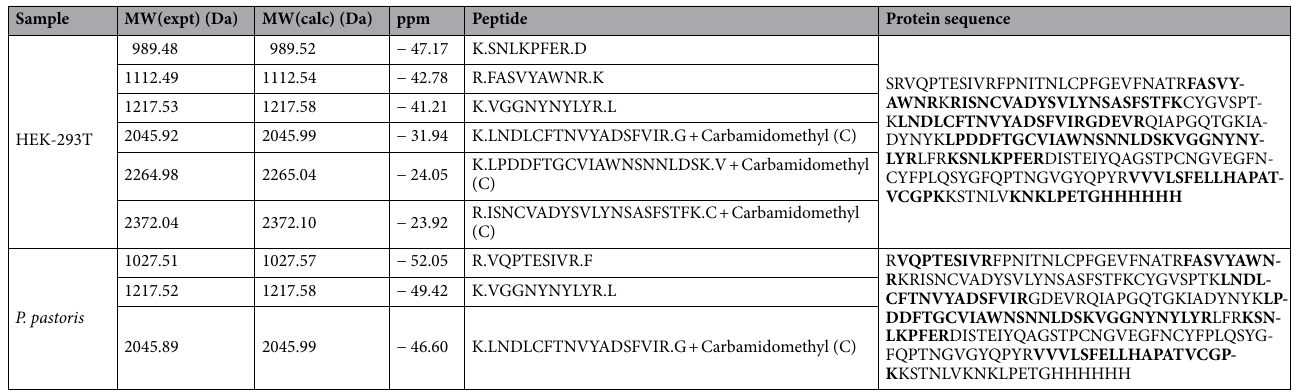
Table 1. MS/MS analysis results for in-solution digestion of RBD obtained from HEK-293T and from P. pastoris . Protein coverage was of ∼ 40 and ∼ 60%, for RBD produced in P. pastoris and HEK-293T cells, respectively. The experimentally obtained (MW (expt)) and the calculated (MW (calc)) molecular weights of the peptides, and their difference (ppM) are shown. The protein sequence of each construct is shown, bold indicate the peptides identified either by MS/MS analysis or peptide mass fingerprint (less than 60 ppm error).